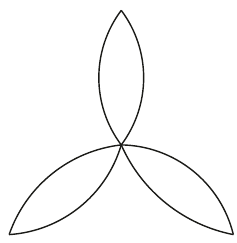
Figure 7. Clover diagram constructed out of the sextic scalar vertex of